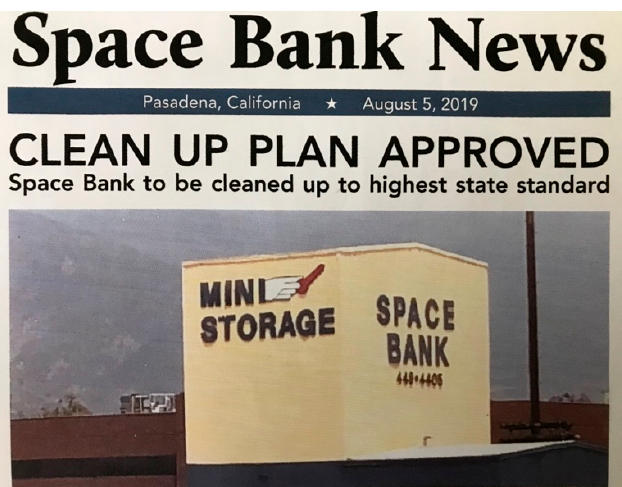
Figure 3. Photo of the first page of a CBRE/TCC brochure, mass mailed to thousands of Pasadena, California residents, that contradicts the cleanup standards contained both in the official CBRE/TCC site documents and in the Covenant Not to Sue that CBRE/TCC negotiated with the state regulator.